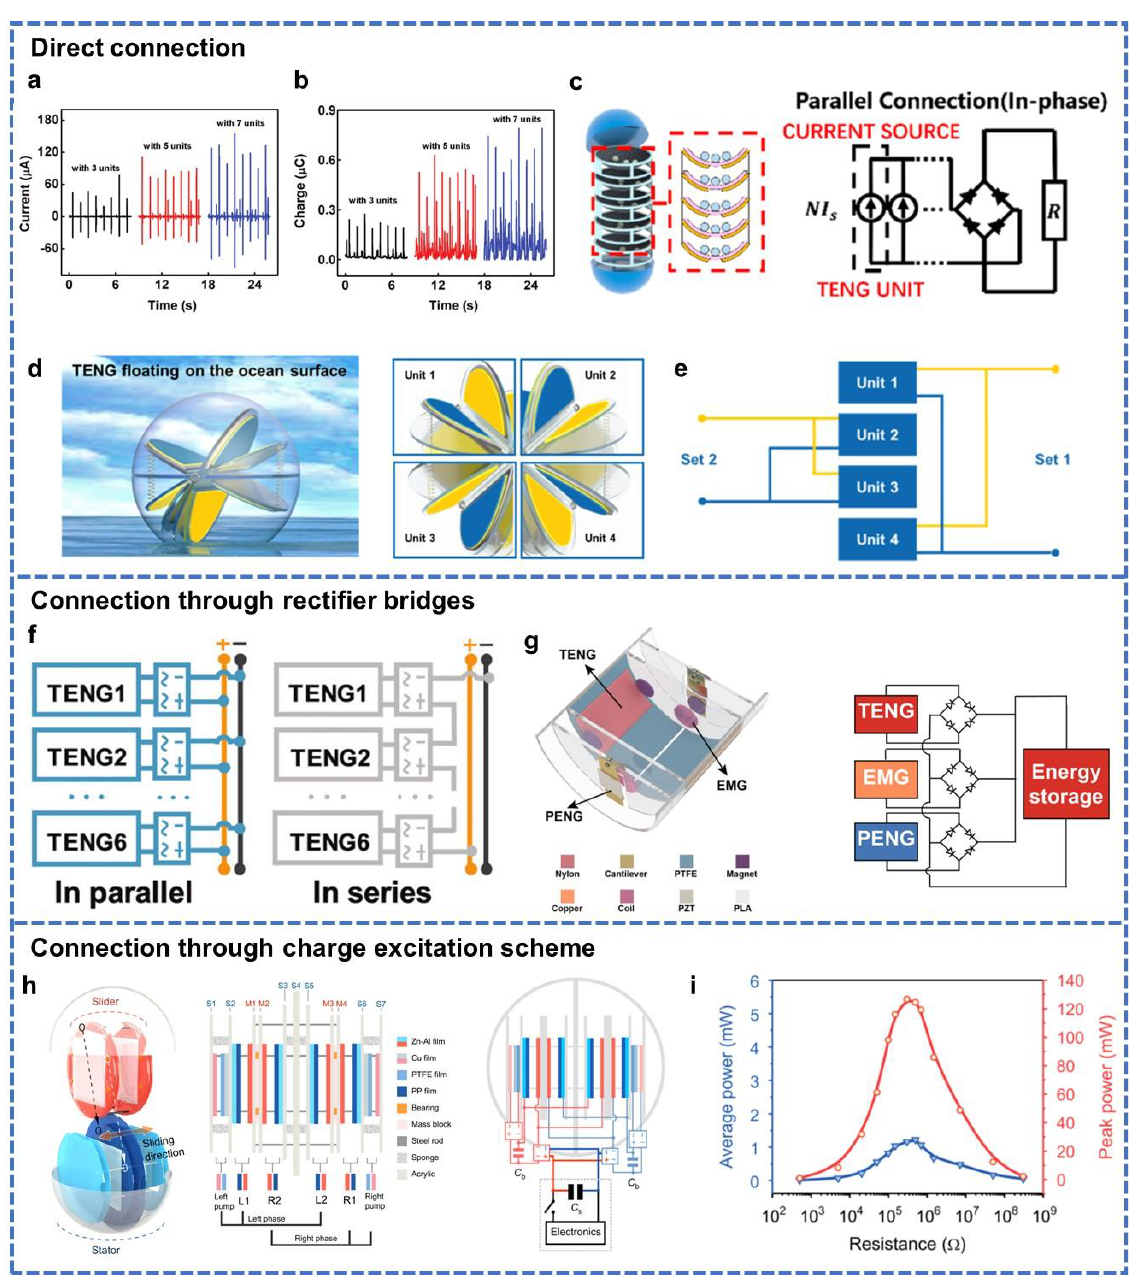
Figure 2. ( a ) Output current and ( b ) transferred charge of the spherical device with the number of the units in the folded structure increasing from three to seven. ( a , b ) Reprinted with permission from ref. [37], Copyright 2018, Wiley. ( c ) Direct parallel connection mode of the tower-like device. Reprinted with permission from ref. [39], Copyright 2019, American Chemical Society. ( d ) Working phase and ( e ) circuit-connection mode of the four TENG units inside the spherical device with spring-assisted swing structure. ( d , e ) Reprinted with permission from ref. [49], Copyright 2021, Elsevier. ( f ) Schematic diagrams for the parallel and series connections between the multilayered TENG units. Reprinted with permission from ref. [43], Copyright 2019, Royal Society of Chemistry. ( g ) Structure and circuit connection of the hybrid nanogenerator gathering a TENG unit, a PENG unit, and an EMG unit. Reprinted with permission from ref. [50], Copyright 2022, Elsevier. ( h ) Spe- cific structure of the high-performance device based on charge shuttling. ( i ) Peak power and average power of the integrated device with various loads in water waves. ( h , i ) Reprinted with permission from ref. [35], Copyright 2020, the authors.